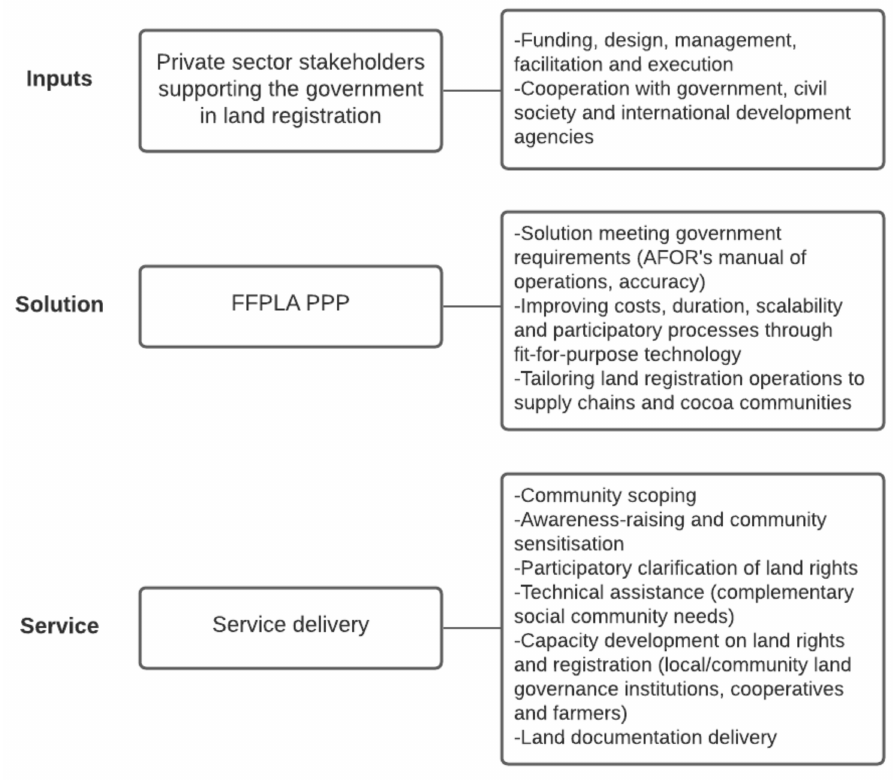
Figure 2. PPP to service delivery processes.